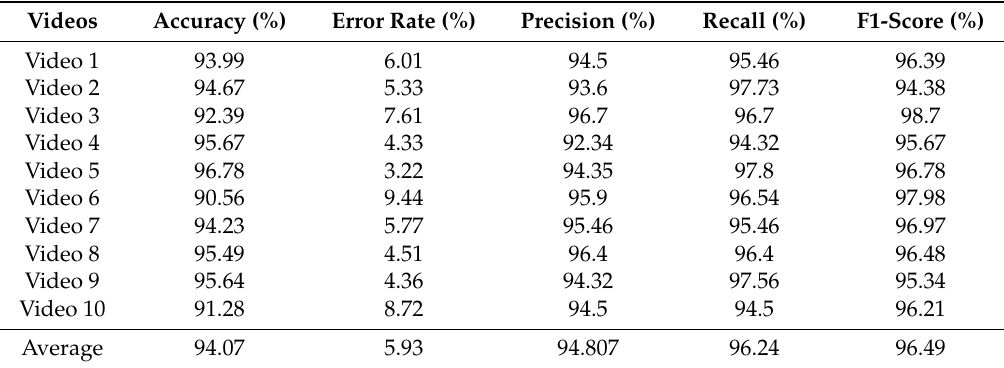
Table 1. Performance evaluation for the proposed